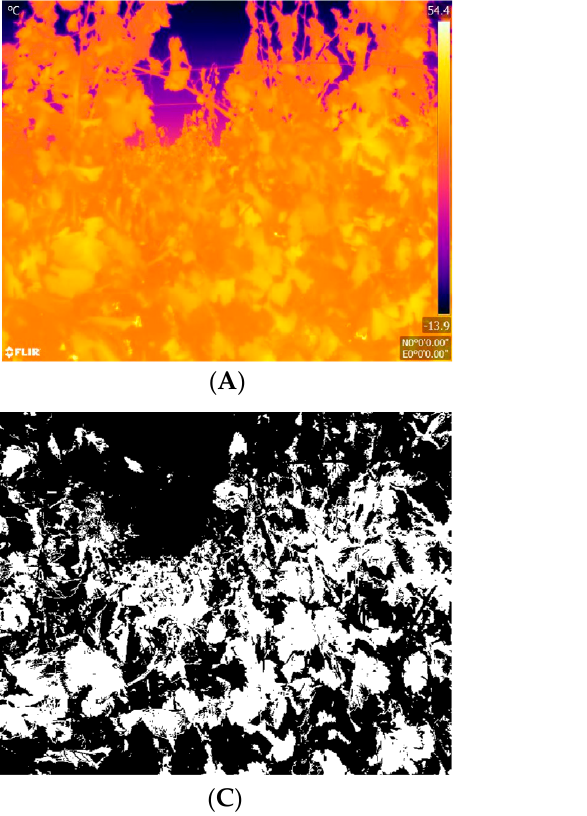
( B ) Figure 4. Performance of the proposed imaging processing algorithm for average T c calculation rel- ative to the manually measured T c in the ( A ) shaded side and ( B ) sunlit side of vine canopies.